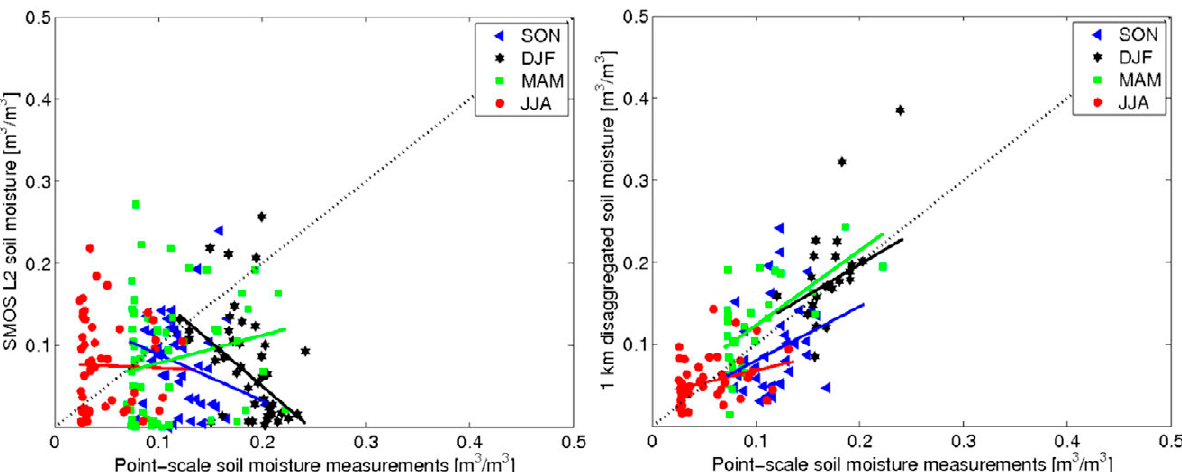
Fig. 16. – Results of the seasonal analysis for the hydrological year starting in September 2010 (afternoon passes) over station 07 (rainfed cere- als). Left, scatter plot of SMOS L2 soil moisture versus point-scale measurements. Right, scatter plot of 1-km SMOS-MODIS disaggregated soil moisture versus point-scale measurements. Segments are linear fit of seasonal (3-month) data (from Piles et al. 2014a).